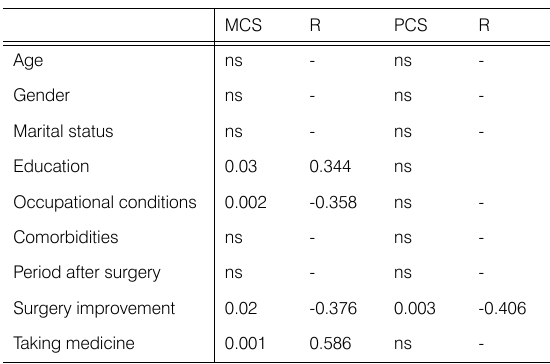
Table 3. Correlations between the PCS (Physical Component Scale) score, the MCS (Mental Component Scale) score and sociodemographic data (p-value, R-Spearman coef- ficient, if statistically significant) in patients after spine surgery (ns-statistically nonsignificant).